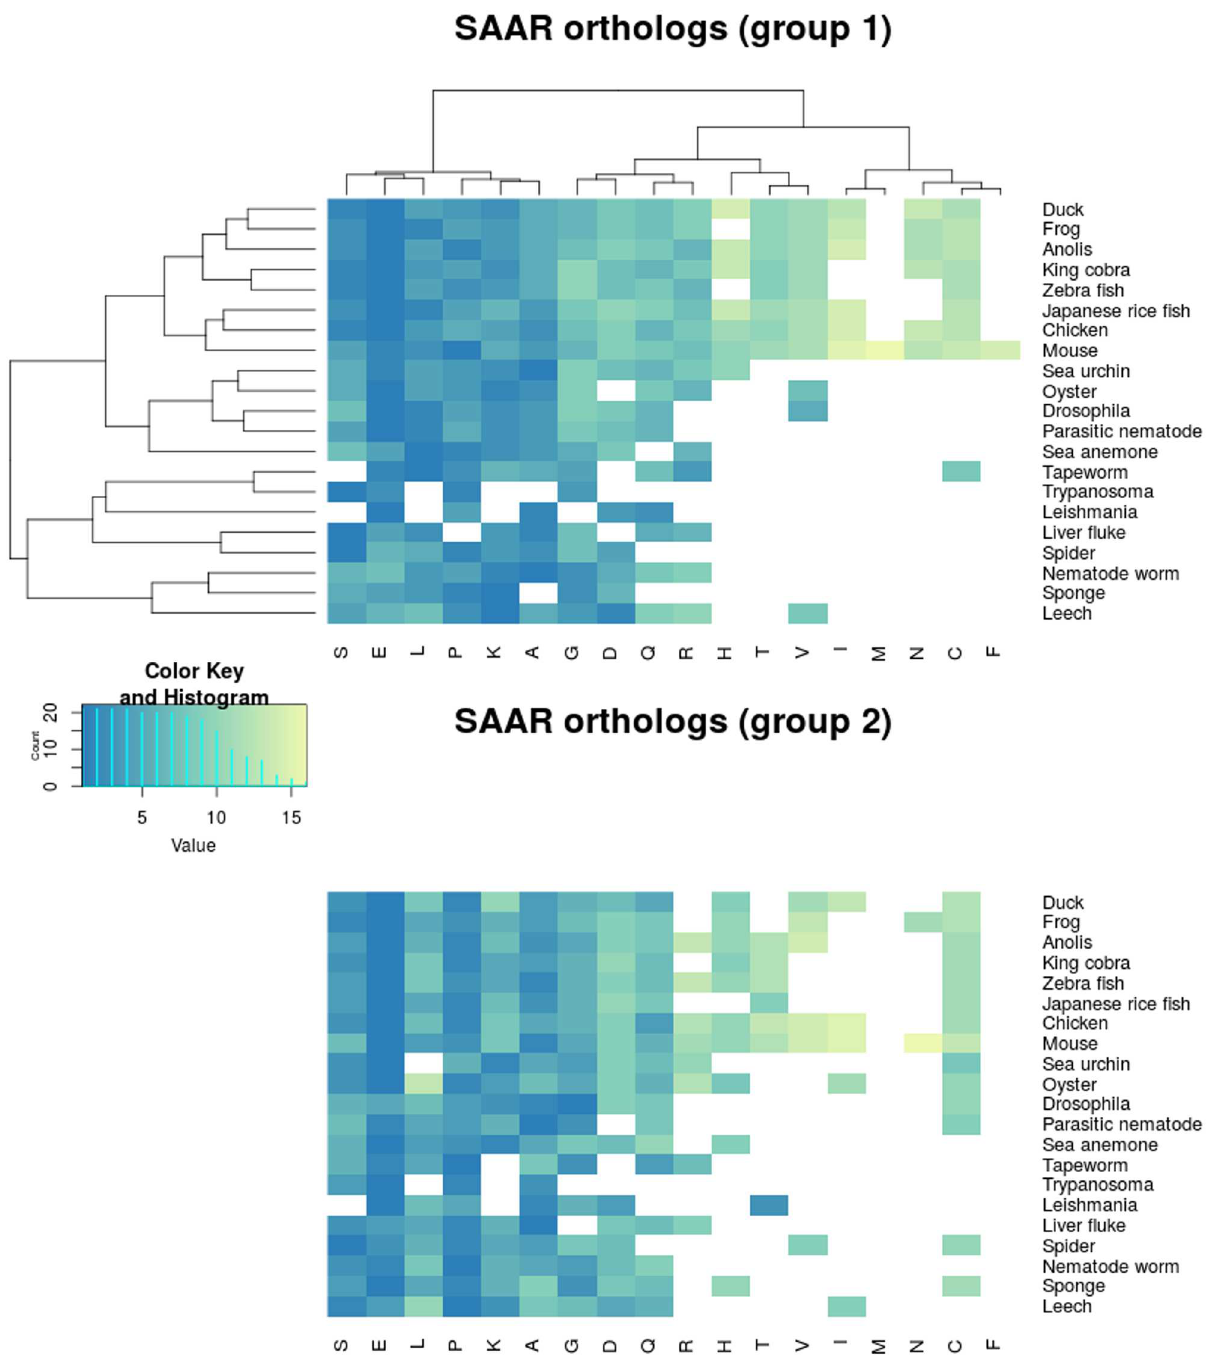
Fig 6. Group 1 and group 2 orthologs. The data shows the SAAR conservation betweenorthologousproteins of severalvertebrate and invertebrateproteomes. Amino acids are rankedby the frequency of conservation (lowervalue indicatesbetter conservation). Group 1 (top) containshuman orthologpairs in which the SAAR events are conservedin terms of events and repeat lengths. Group 2 (bottom) contains human orthologpairs that are conservedby the numberof events but not their repeat length. Group 1 is two way clustered to group amino acids and specieswith similar conservation. Group 2 follows the order of amino acids and species of group 1 to allow an easiercomparison betweenplots.